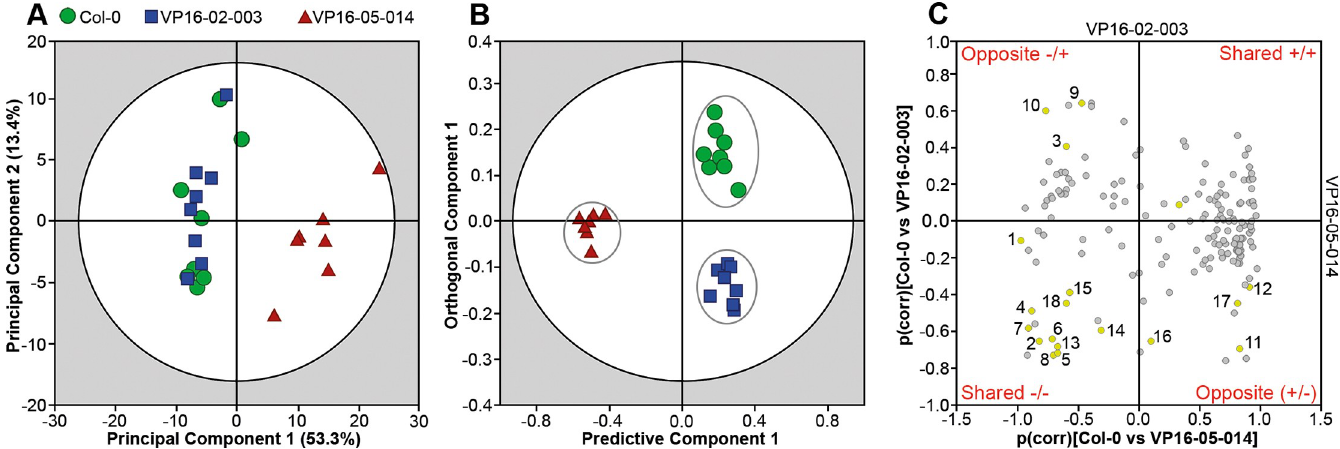
Fig 3. Multivariate analysis of 1 H HR-MAS NMR metabolic data collected from Arabidopsis thaliana Col-0 (•), VP16-02-003 ( ■ ) and VP16-05-014 ( ▲ ). (A) PCA score plot with R 2 X = 0.761 and Q 2 = 0.611. The dark circle shows the 95% confidence interval using Hotelling T 2 statistics. (B) OPLS-DA score plot with R 2 X = 0.849, R 2 Y = 0.942, Q 2 = 0.603, which indicates separation between the Col-0, VP16-02-003 and VP16-05-014 Arabidopsis plants based on their metabolic profile. The dark circle represents the Hotelling T 2 interval with 95% confidence. (C) SUS plot represents biomarkers responsible for the separation in the score plot. 1. Fumaric acid; 2. Malic acid; 3. Lactic acid; 4. Fructose; 5. Glucose; 6. Myo-inositol; 7. Choline; 8. Betaine; 9. L-alanine; 10. β -alanine; 11. L-asparagine; 12. L-aspartic acid; 13. L-glutamic acid; 14. L-glutamine; 15. L-glycine; 16. L-lysine; 17. L-phenylalanine; 18. L-tyrosine.